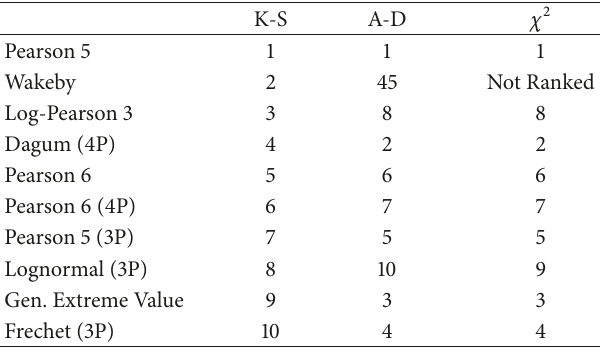
Table 3: Distributionranking according to the threegoodness-of-fit methods for all drivers at the speed interval [90, 108[